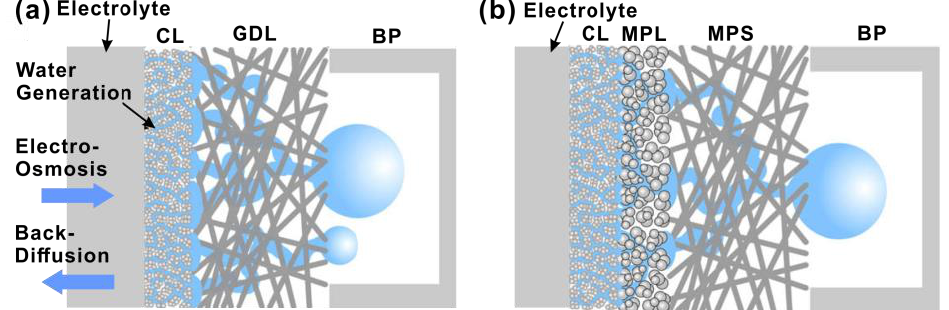
Figure 4. Schematic illustrations showing water transport in the cathode: ( a ) without and ( b ) with the MPL. Reproduced with Permission [51]. Copyright 2009, Elsevier.